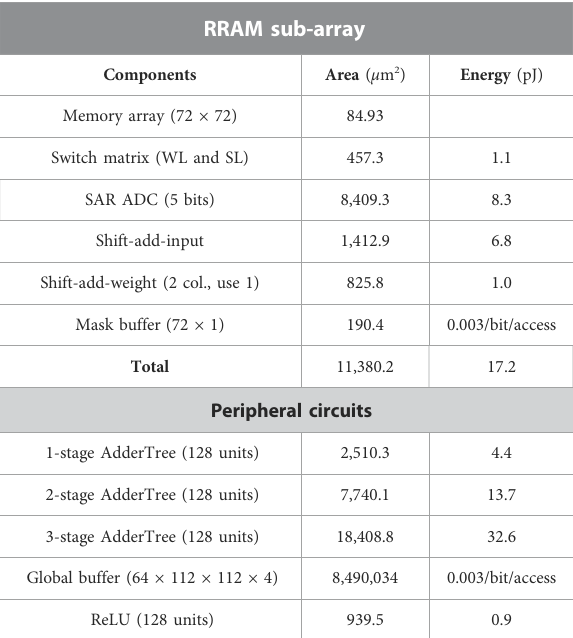
TABLE 4 Speci fi cation of ReRAM hardware and peripheral